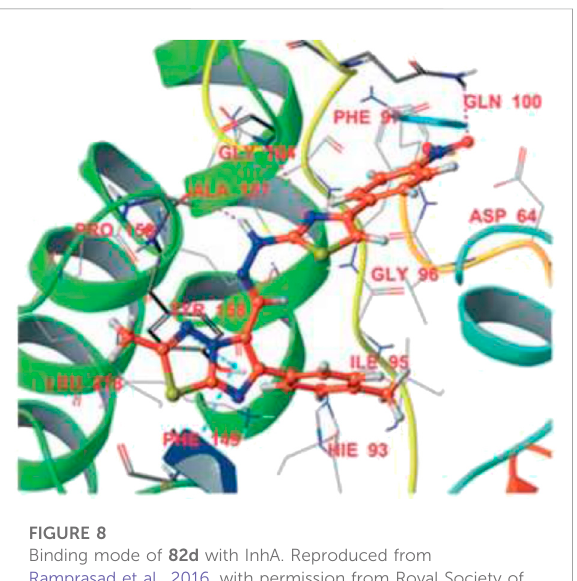
FIGURE 8 Binding mode of 82d with InhA. Reproduced from Ramprasad et al., 2016, with permission from Royal Society of Chemistry, Copyright